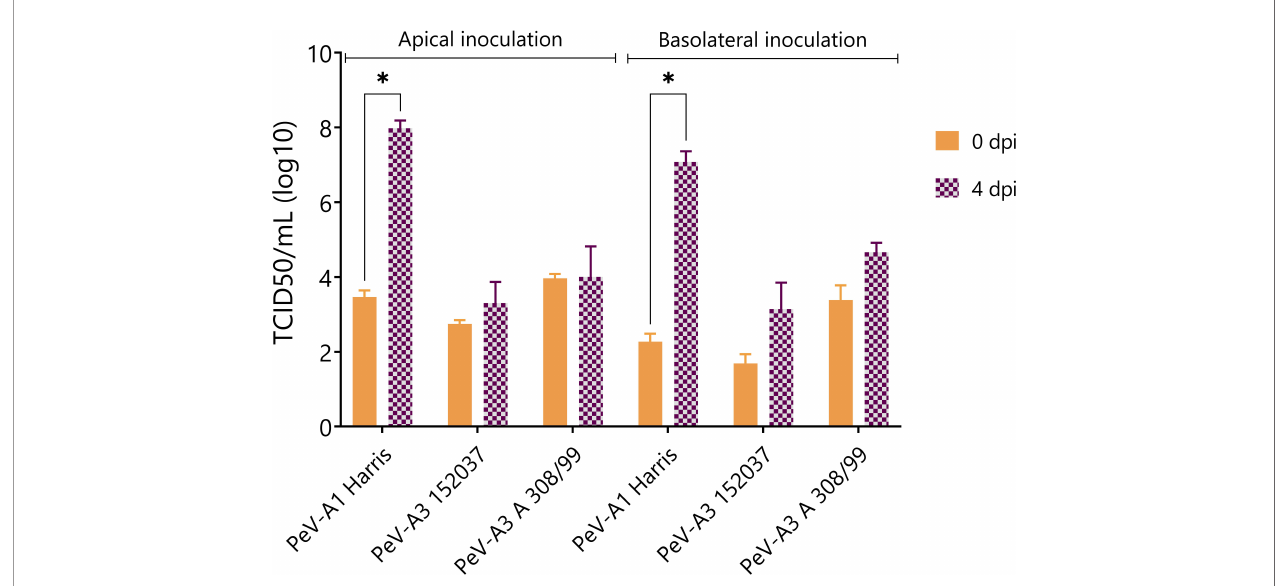
FIGURE 3 | Virus titer at 0 and 4 dpi of apically collected samples. Titers were determined by TCID50. In all cases, data represent the mean ± SEM of two technical replicates in three biological replicates. * p -value < 0.05. dpi = days post